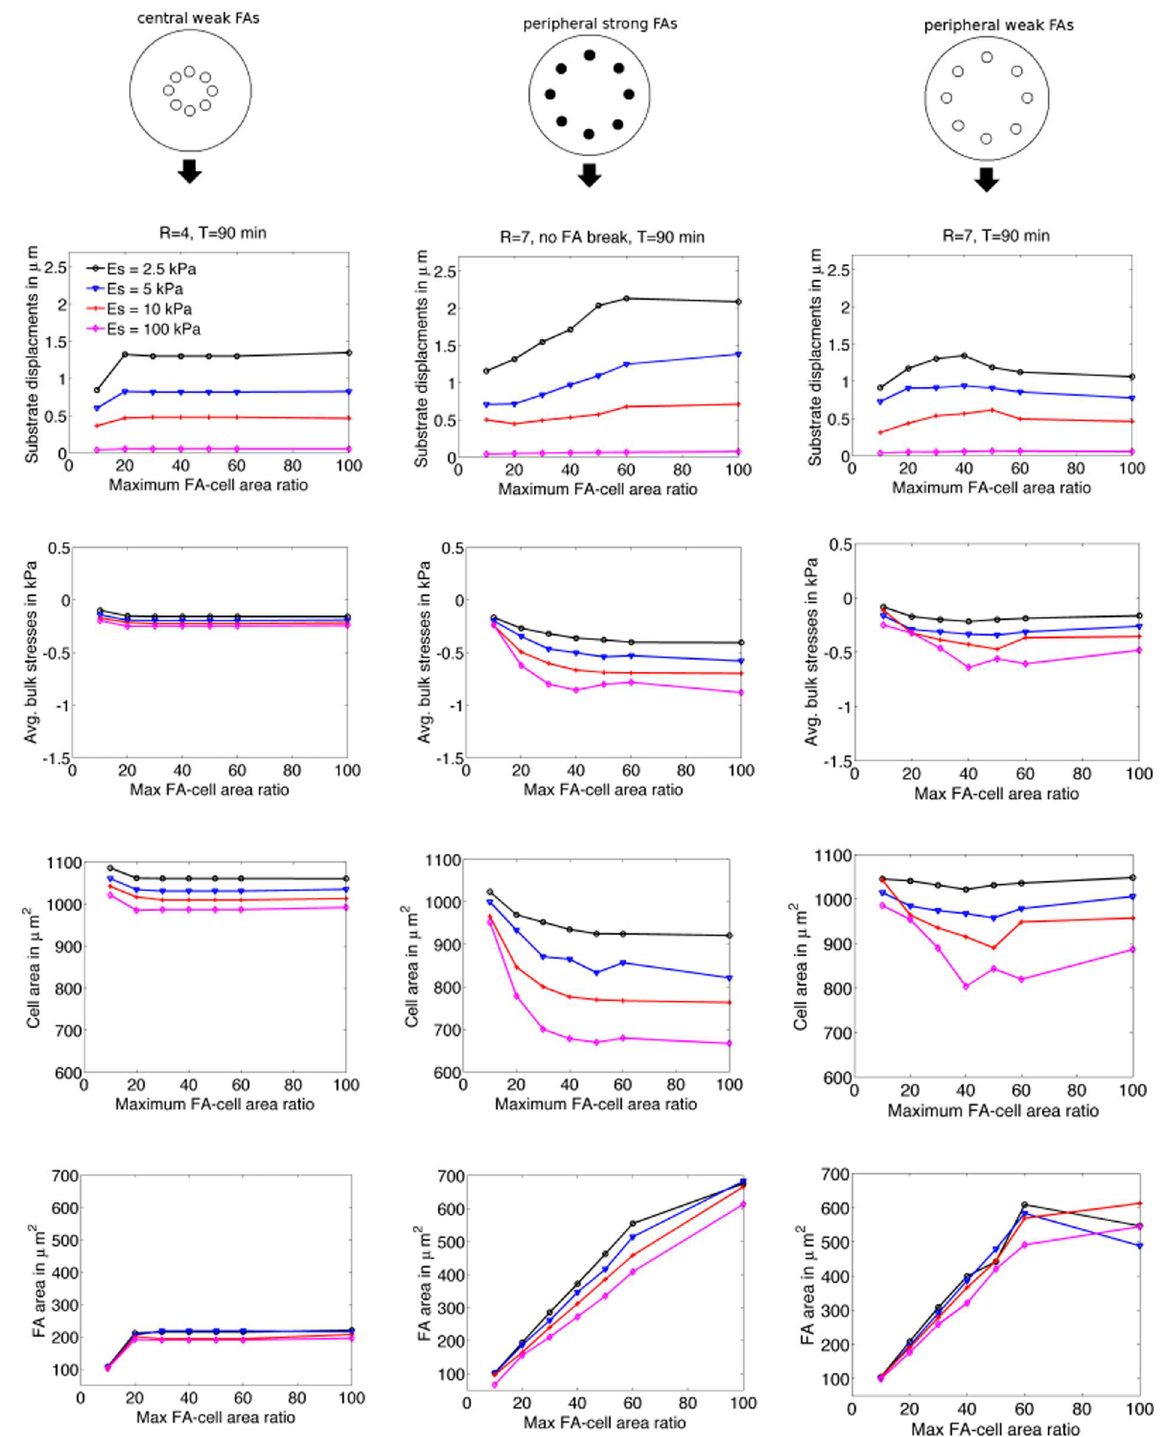
Fig 6. Effects of critical FA-cell area ratio and substrate stiffness on cell response. The horizontal axis represents variationsin critical FA-cell area ratio, whileline colors/markers correspond to different substrate stiffnesses; the legendfor all figures is illustrated in the top left graph. The first column of graphs corresponds to data for cells with central, weak FAs (R = 4), the second column correspondsto peripheral, strong FAs (R = 7, no FA break), and the third column corresponds to peripheral, weak FAs (R = 7).